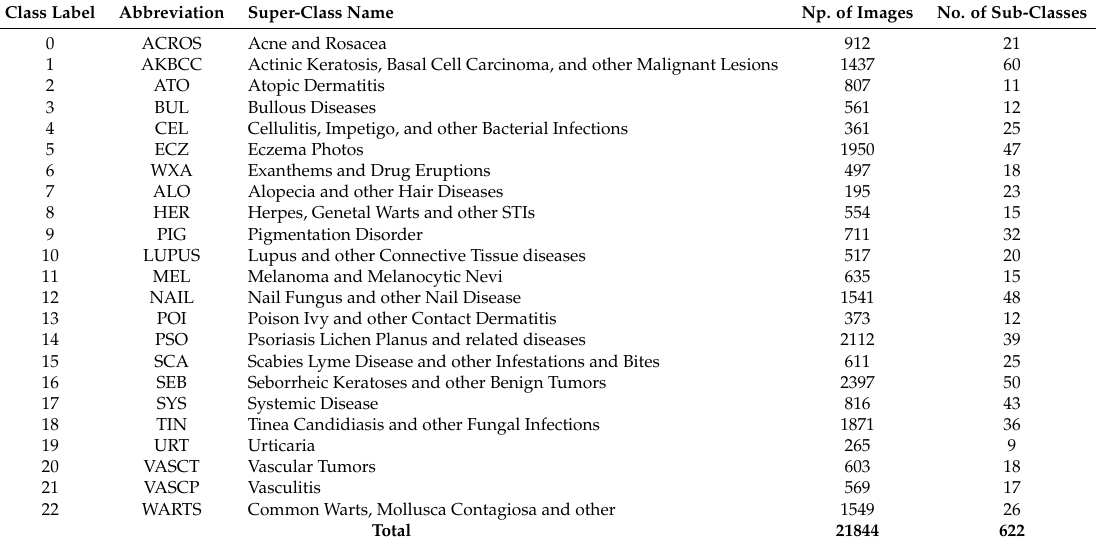
Table 1. Overview of DermNet Dataset and Distribution of Classes.